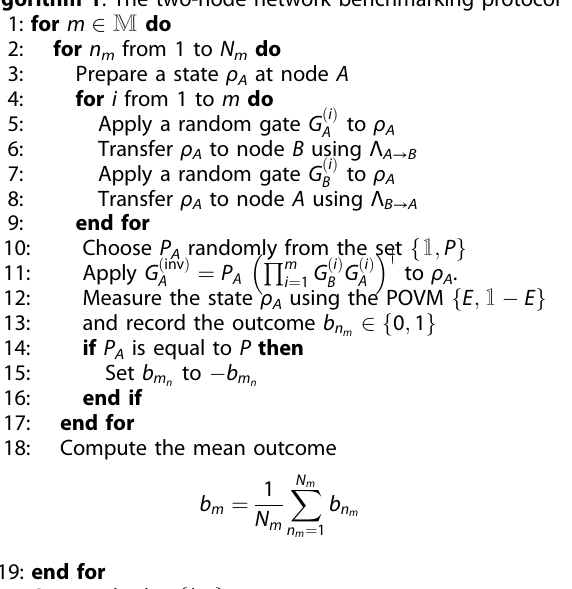
Algorithm 1 . The two-node network benchmarking protocol 1: for m 2 M